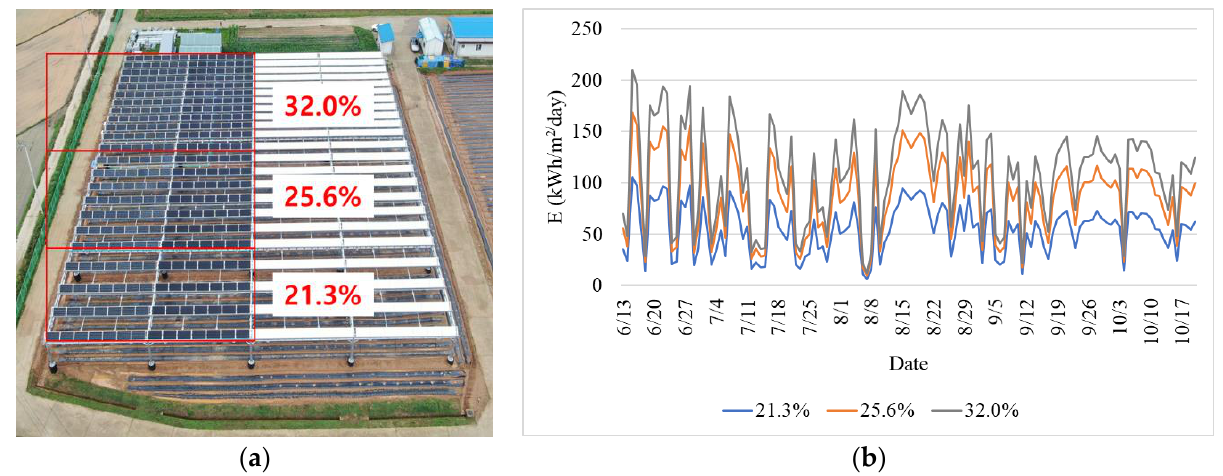
Figure 1. Subject APV system: ( a ) APV structure; ( b ) Electricity generation by the APV system. APV: Agrophotovoltaic [7].